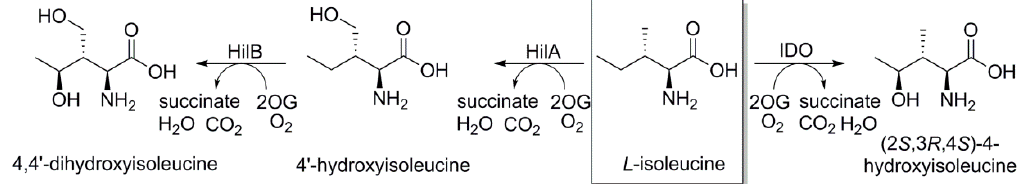
Figure 4. Enzymatic L -isoleucine hydroxylation. Right: L -isoleucine dihydroxygenase (IDO)-catalyzed derivatization of L -isoleucine to form (2 S ,3 R ,4 S )-4-hydroxyleucine; Left: Subsequent reaction of L -isoleucine with HilA and HilB to generate the dehydroxylated 4,4’-dihydroxyisoleucine.